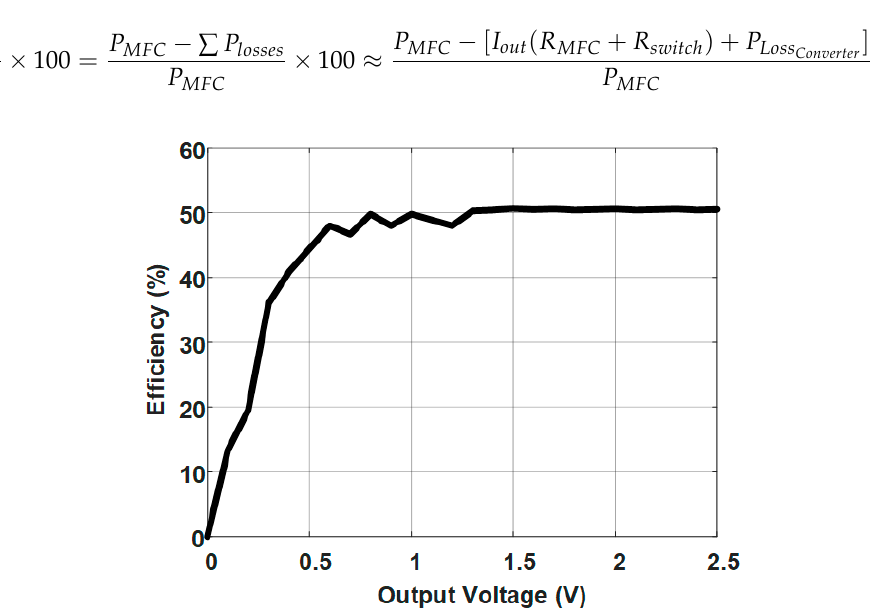
Figure 11. Measured Efficiency versus Output Voltage.